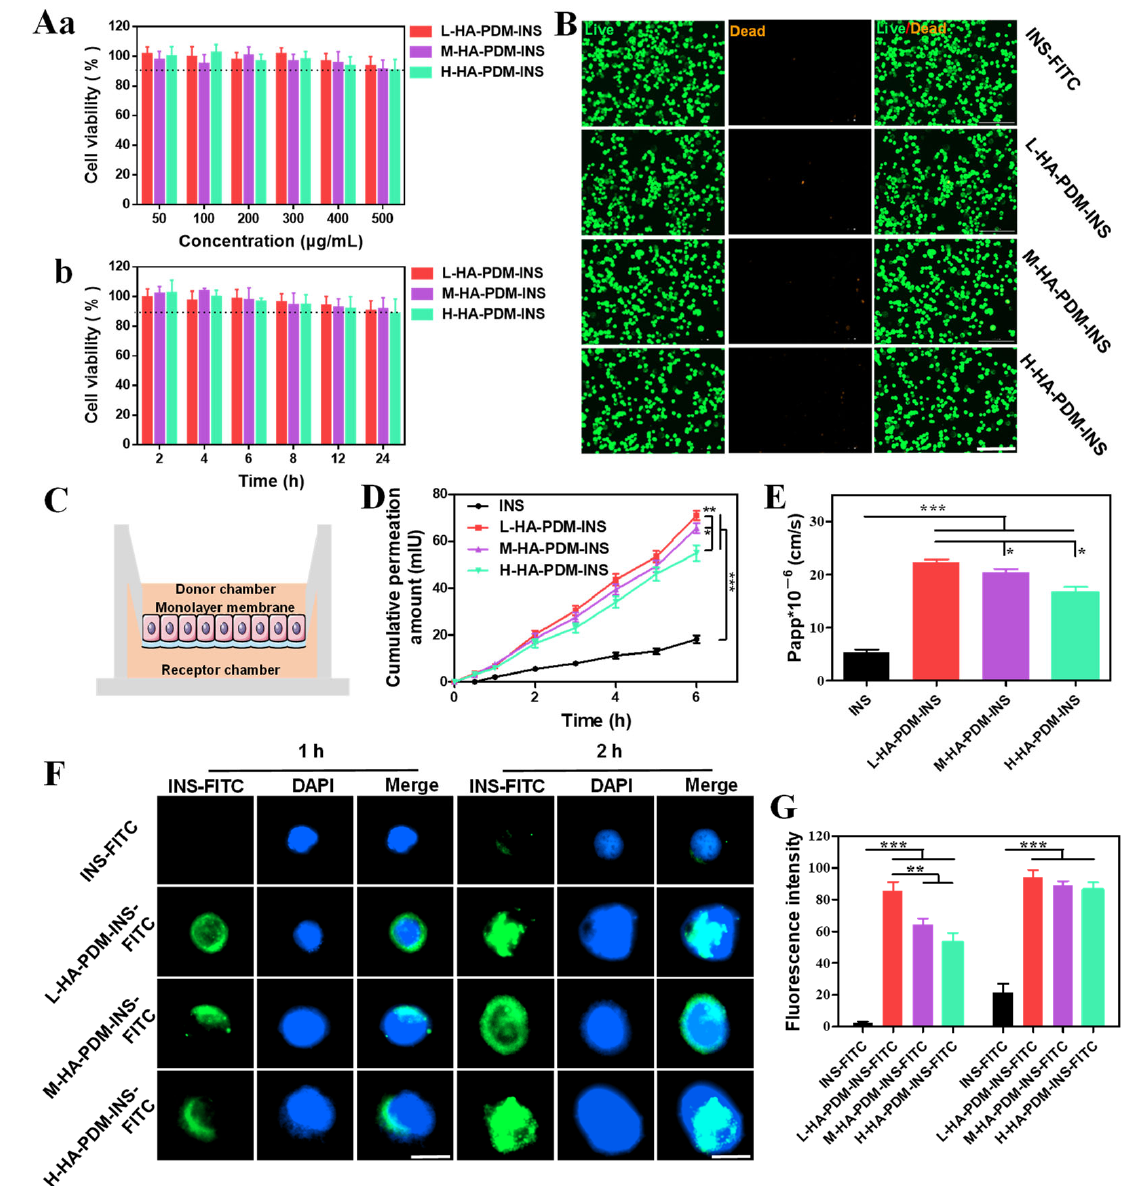
Figure 7. Effect of three nanoparticles with distinct concentrations ( A ( a )) and different time ( A ( b )) on the Caco-2 cells viability. ( B ) Live/dead staining of Caco-2 cells after incubation with the different nanoparticles for 1 d. The living cells were dyed green, and the dead cells were dyed orange, scale = 200 µ m. ( C ) Schematic diagram of the Caco-2 cells monolayer barrier. ( D ) In vitro permeation studies of insulin from different nanoparticles across the Caco-2 cells monolayer barrier (X ± SD, n = 6, * p < 0.05, ** p < 0.01, *** p < 0.001). ( E ) Papp of insulin across Transwell after 6 h (X ± SD, n = 6, * p < 0.05, *** p < 0.001). ( F ) Cellular uptake of INS–FITC, L ‐ HA–PDM–INS–FITC, M ‐ HA–PDM–INS–